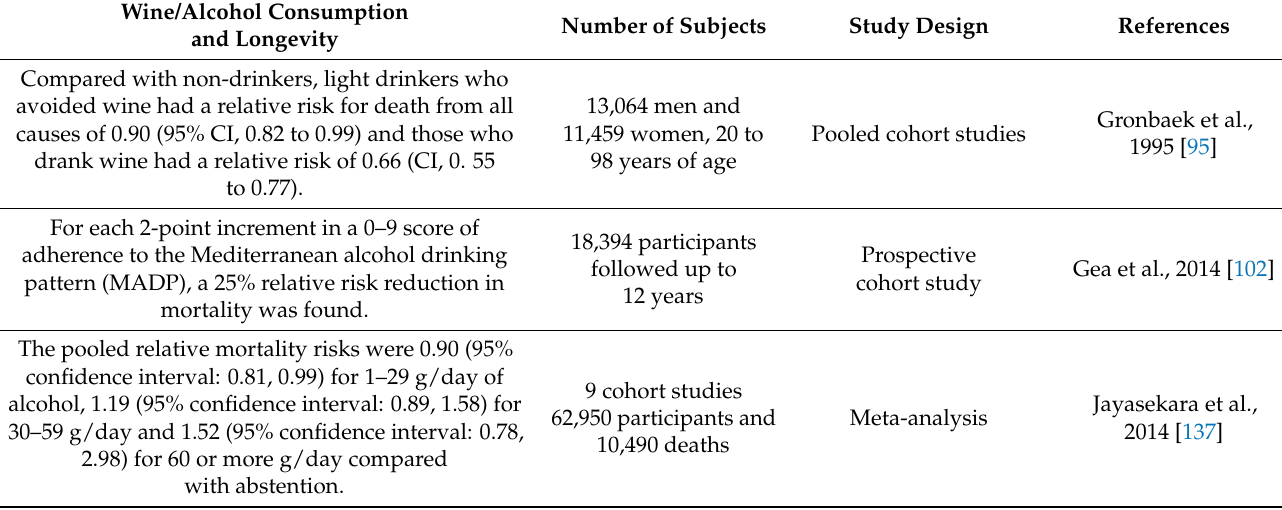
Table 5. Studies on wine consumption and